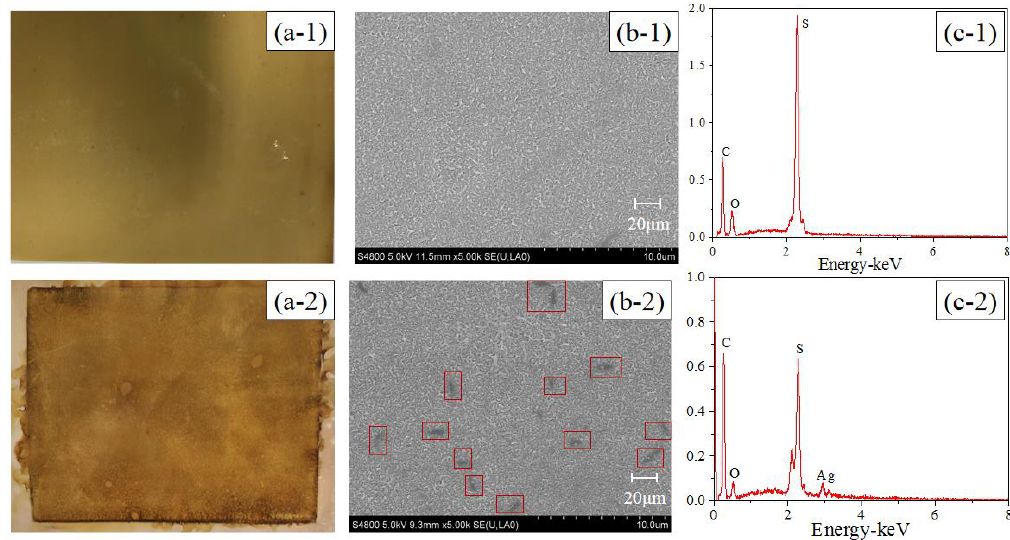
Figure 2. ( a ) Photographic images, ( b ) SEM images, and ( c ) EDX analyses of (1) the pristine and (2) the modified active layer of the TFC–FO membranes.